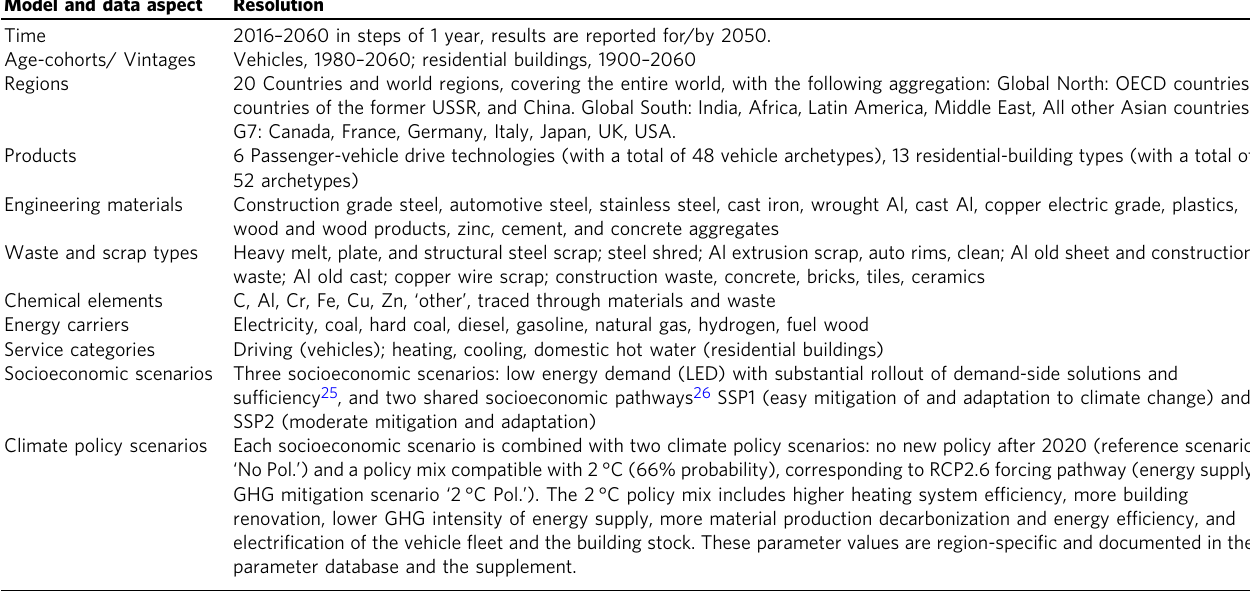
Table 1 RECC v2.4 data aspects and their